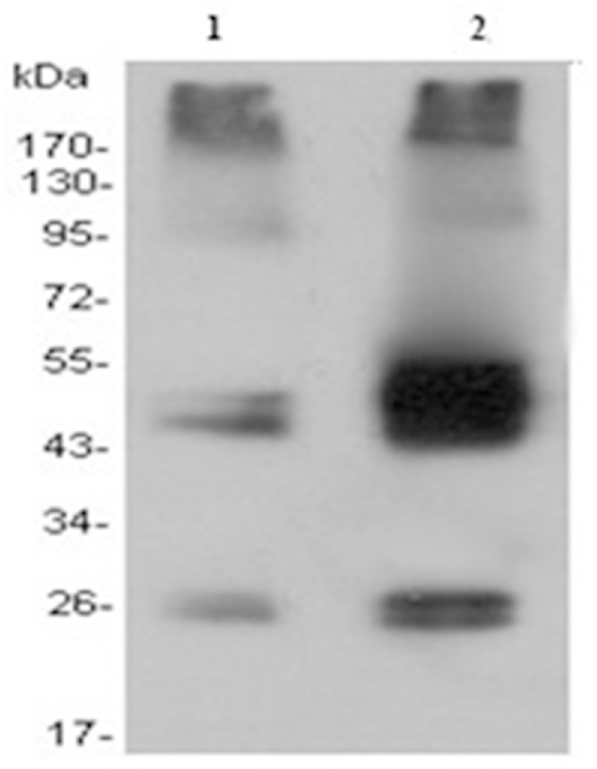
Fig 2. Western blot analysis of membrane protein extracts isolated from instantaneous transfected and nontransfected HEK293 cells. Equal amounts of proteins were loaded for each of the strains, separated by gel electrophoresis, and Western blotted with anti-His monoclonal antibodies. Membrane protein extracts of nontransfected (lane 1) and instantaneous transfected (lane 2) HEK293 cells, (lane M) molecular weight standards. The receptor produced in HEK293 cells appeared in cellulose acetate membrane as diffuse bands with an apparent molecular mass between 43 and 55 kDa.